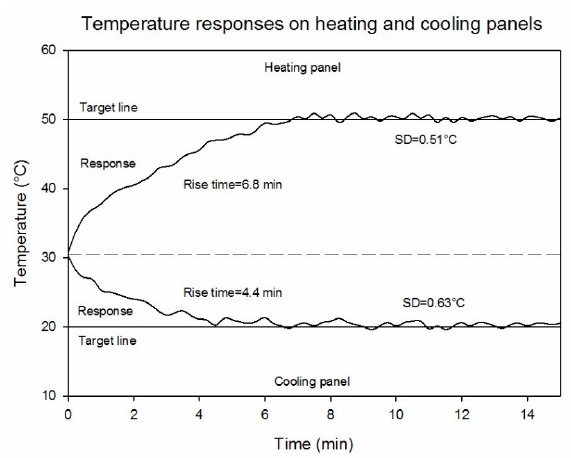
Figure 7. Temperature responses and stabilities of the temperature-controlled references.